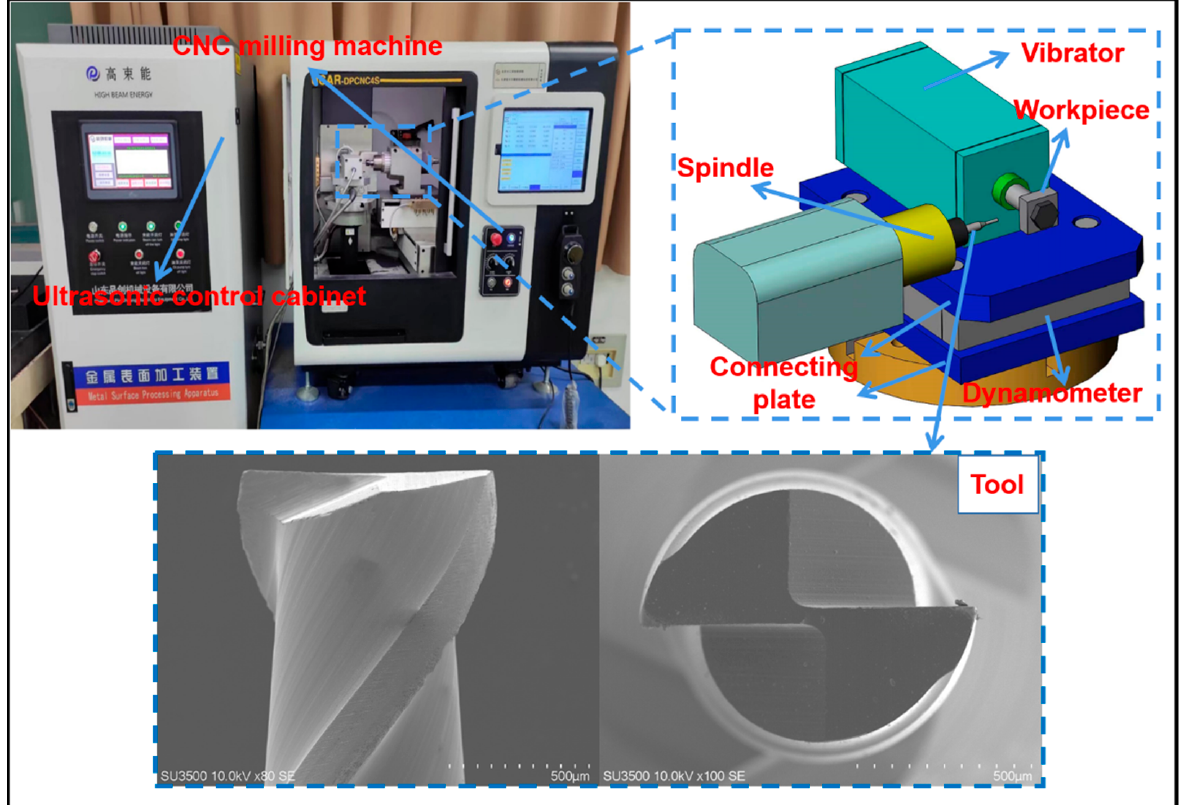
Figure 2. Experimental